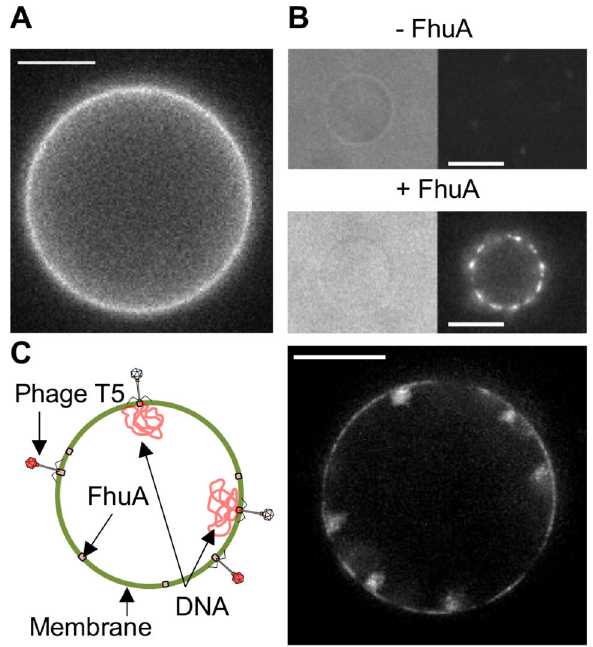
Figure 1. T5 DNA ejection process reconstituted in GUVs. A\ Fluorescence image of a GUV reconstituted at a DPhPC/FhuA-Alexa568 ratio of 100 w/w. B\ Combined brightfield (left) and Yo-Pro I fluorescence image (right) of DPhPC GUVs with FhuA (+FhuA) or without FhuA (-FhuA). Fluorescent dots correspond to individual phage particles stained with Yo-Pro I. Phages are either unbound (-FhuA, diffusing rapidly in solution: low fluorescence intensity) or bound to the vesicle surface (+FhuA, slow diffusion of phages on the vesicle surface: high fluorescence intensity). C\ Left: Schematic representation of bound phages that have released or not their intracapsid DNA onto the vesicle lumen. Right: Yo- Pro I fluorescence image of a DPhPC/FhuA GUV (100 w/w ratio) after 20 minutes of incubation with T5 phages (10 10 pfu/ mL). The image is a maximum intensity projection over time (30 frames taken at 10 fps). The time projection emphasizes the difference between a sharp fluorescence coming from the vesicle surface and the ‘cloudy’ fluorescence coming from the vesicle lumen. The sharp fluorescence corresponds to weakly stained phages bound to the vesicle that have not ejected their DNA. The ‘cloudy’ fluorescence comes from DNA molecules that have crossed the membrane, after their ejection by phages. 6 highly fluctuating individual DNA molecules can be distinguished, which remain attached at the vesicle